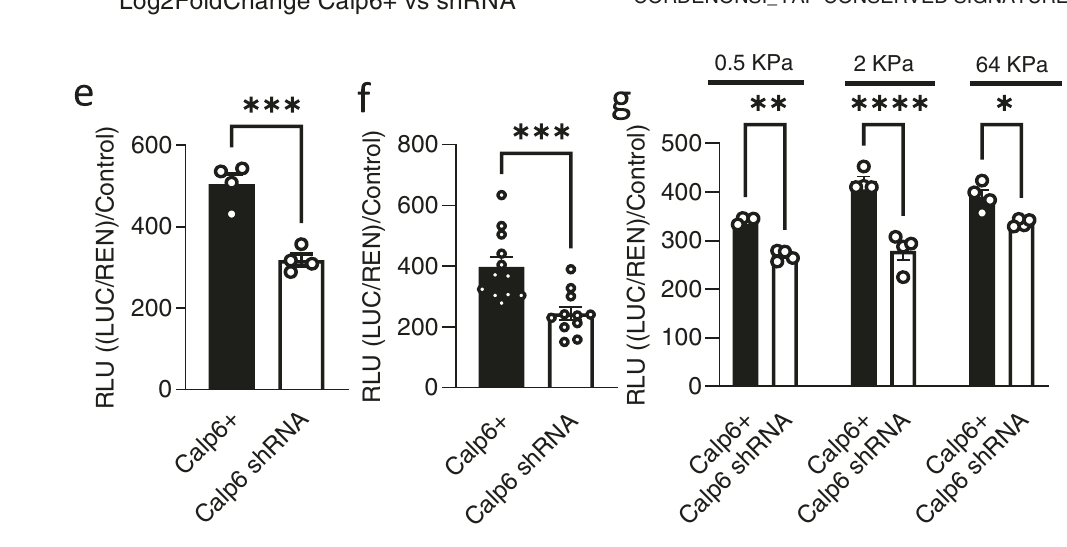
Reactome Pathway Analysis highlighted a differential expression of genes involved in the Mitotic G2/M phase, G2M transition and M phase in Calp6-P-GFP + cells (Supplementary Fig. 2c, f). GSEA further showed that basal calpain-6 expression but not over- expression in 143B cells was associated with a gene signature